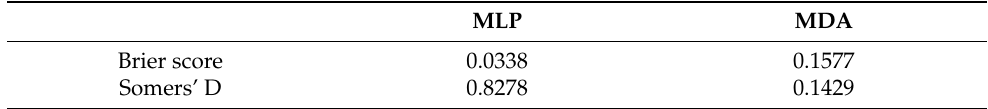
Table 12. Evaluation of models‘